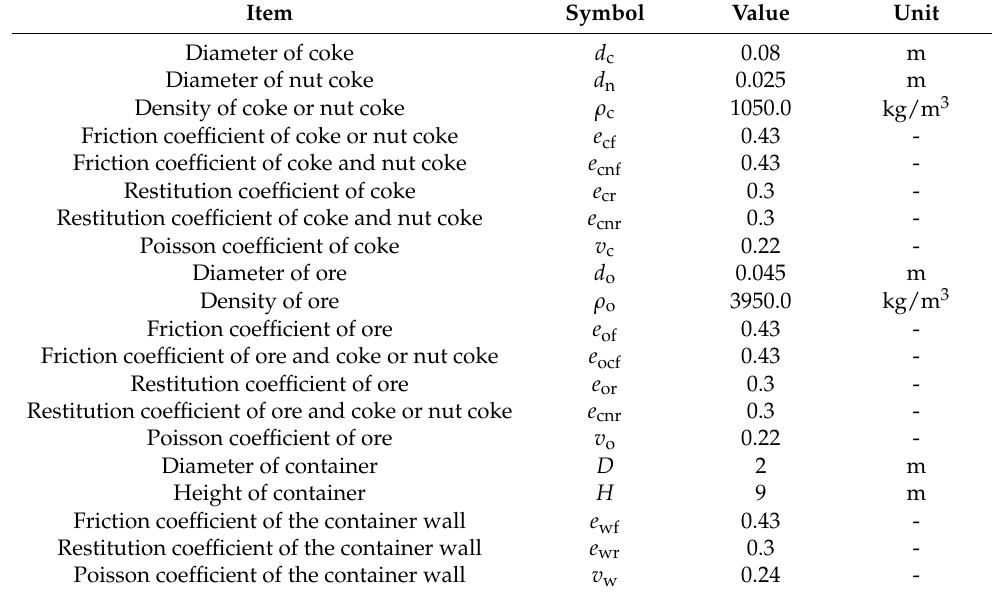
Table 2. Computational conditions and material properties.